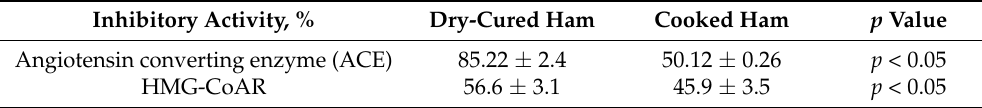
Table 2. Inhibitory activities of interventional and placebo-control meat